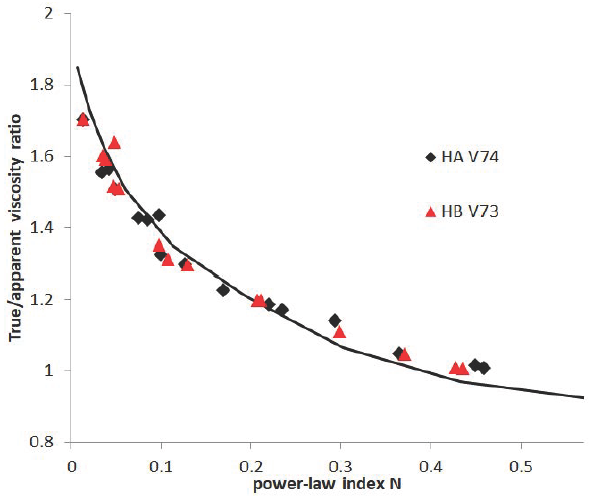
Figure 4: True to apparent viscosity values ratio plotted against the curves slope (flow index) estimated as explained in the test at RPM=1. Points correspond to the actual experimental data, solid